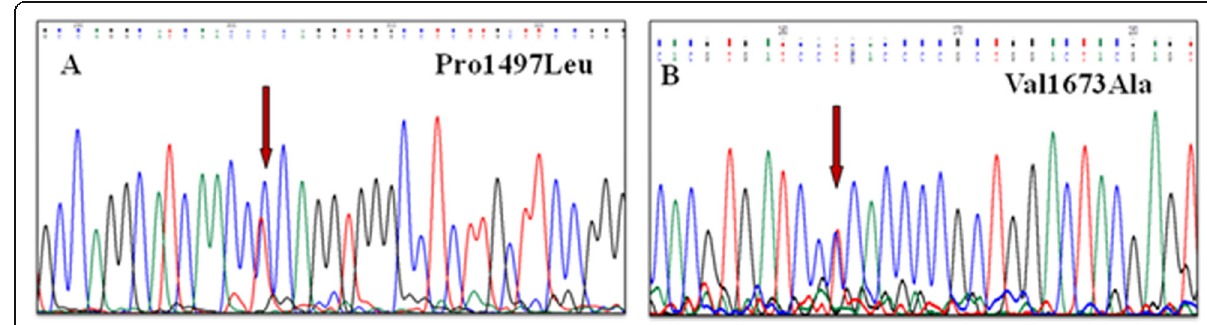
Fig. 5 Electropherogram showing variants identified in Domain 3, ( a ) Pro1497Leu ( b ) Val1673Ala, of tuberin